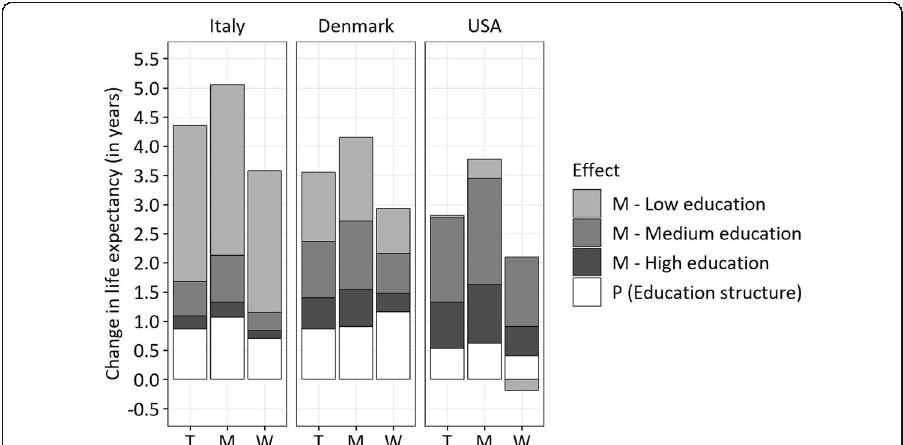
Fig. 1 Absolute contributions of changes in mortality (M effect) and populations ’ educational structure (P effect) to differences in life expectancy at age 30 (in years) for Italy (1991 – 2011), Denmark (1990 – 2010), and the USA (1990 – 2010), stratified by gender. Source: authors ’ own calculations; the data sources for the three populations can be found